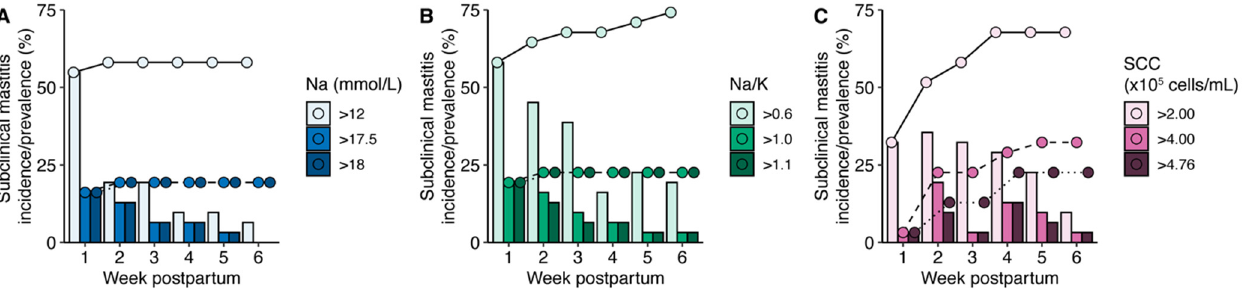
Figure 6. Incidence and prevalence of subclinical mastitis in healthy participants ( n = 31) across the first 6 weeks postpartum based on ( A ) Na concentration, ( B ) Na/K, and ( C ) SCC thresholds. Subclinical mastitis was defined as exceeding biomarker thresholds that have been reported in the literature or empirically derived in this report. Bars indicate incidence of subclinical mastitis within each week, and connected points represent cumulative prevalence of subclinical mastitis over time.